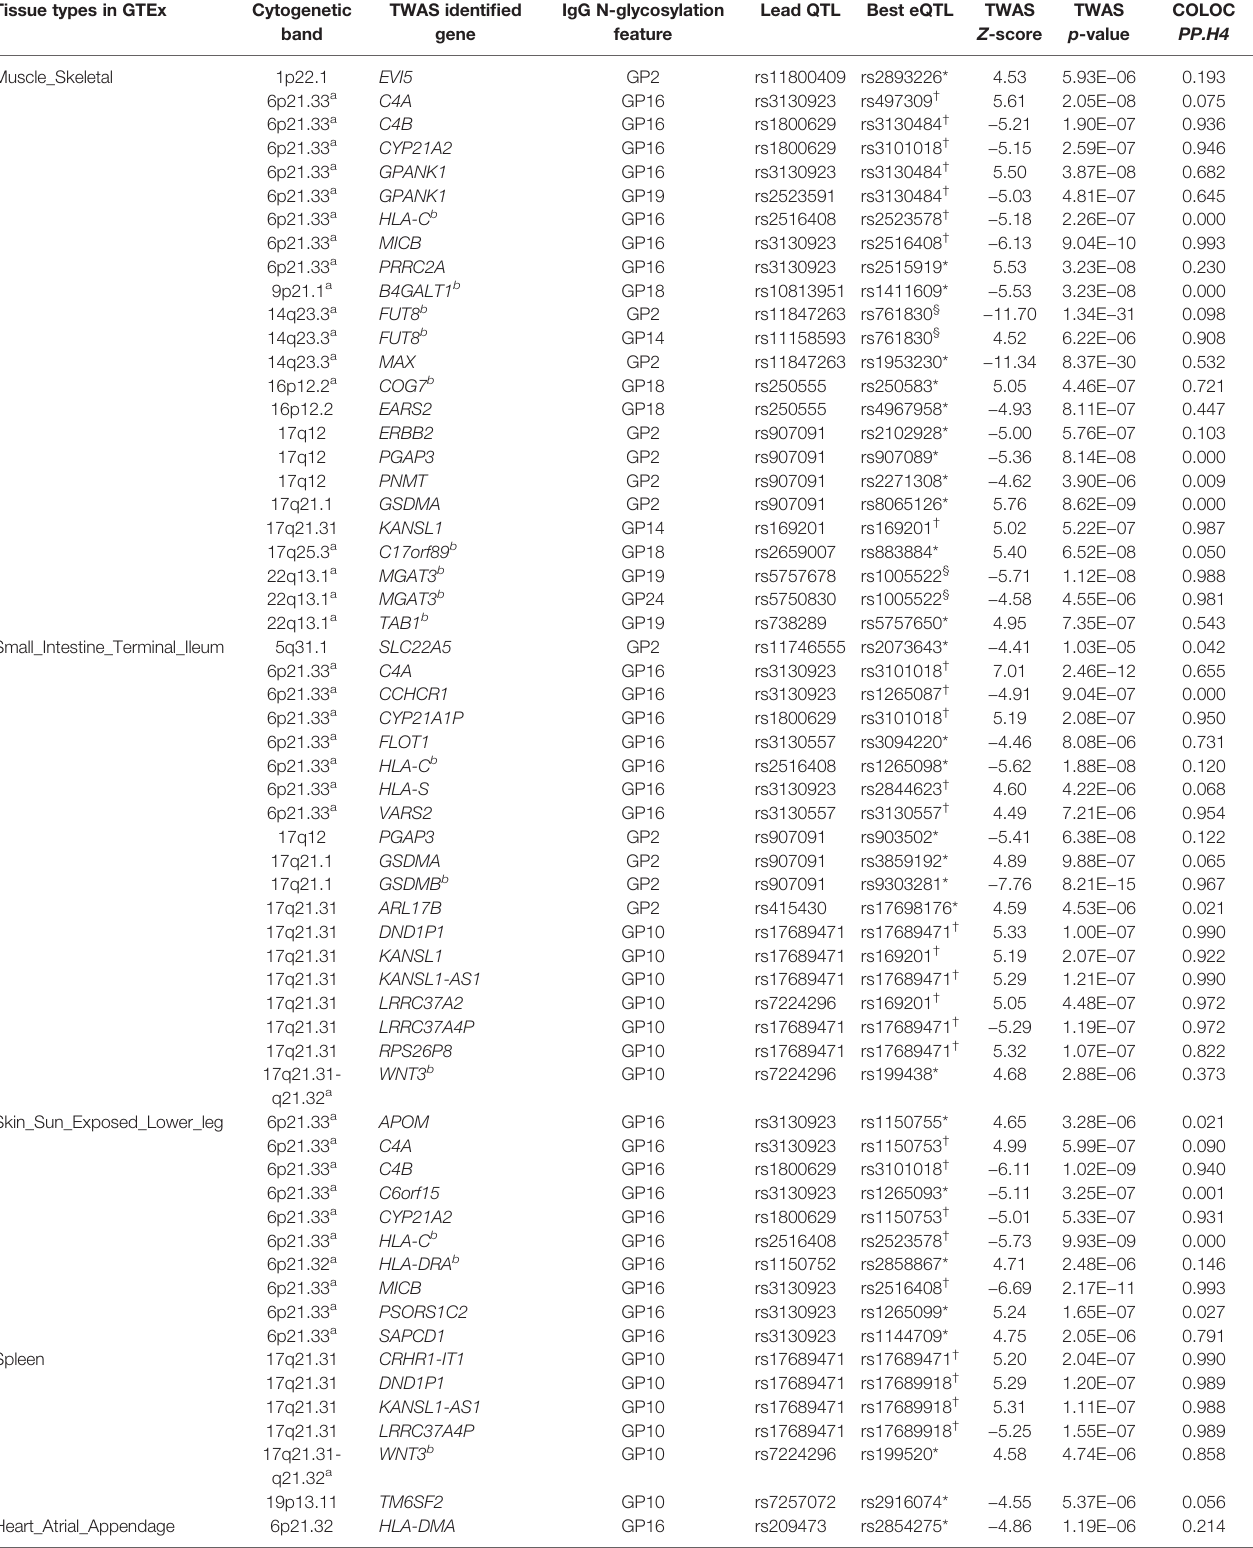
TABLE 1 | Signi fi cant TWAS genes for IgG N-glycosylation